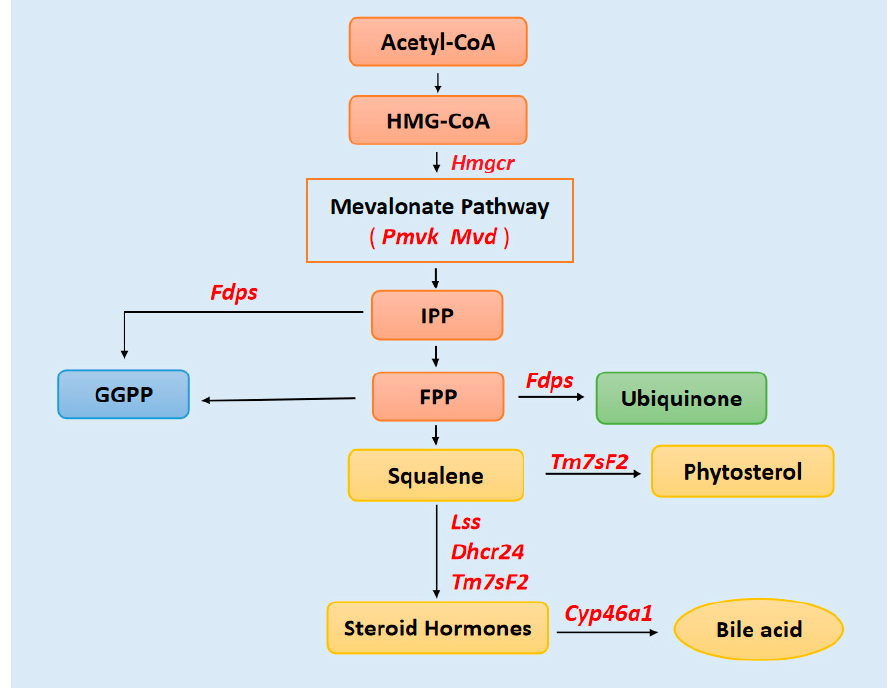
Figure 8. Key genes that might regulate the lipid metabolism by the mevalonate (MVA) pathway. The end product of glycolysis, acetyl-CoA, is metabolized through several enzymatic steps to cholesterol, ubiquinone, FPP, and GGPP. Key genes in tumorigenesis are highlighted in bold. IPP: isopentenyl pyrophosphate; FPP: farnesyl pyrophosphate; GGPP: Geranylgeranyl pyrophosphate.